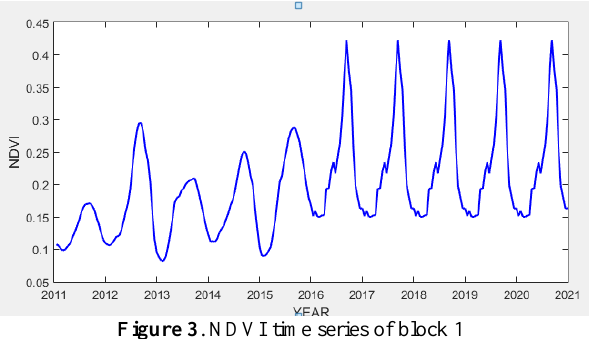
Figure 3 . NDVI time series of block 1